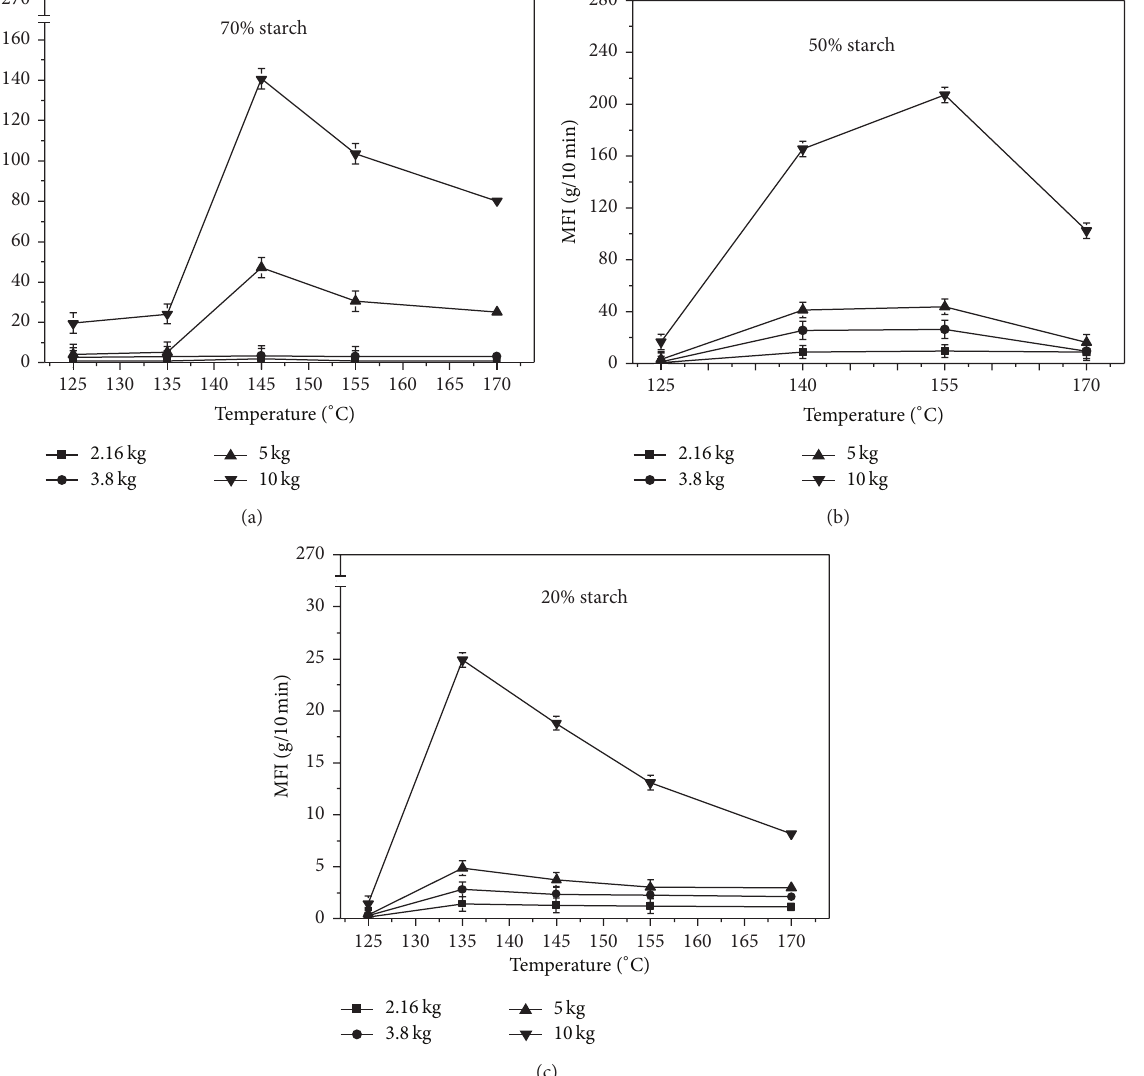
Figure 1: The MFI’s dependency on temperature, load, and starch content for the blends with 70% (a), 50% (b), and 20% (c) starch (line only for eliminating the confusions regarding the symbols’ affiliation to a certain